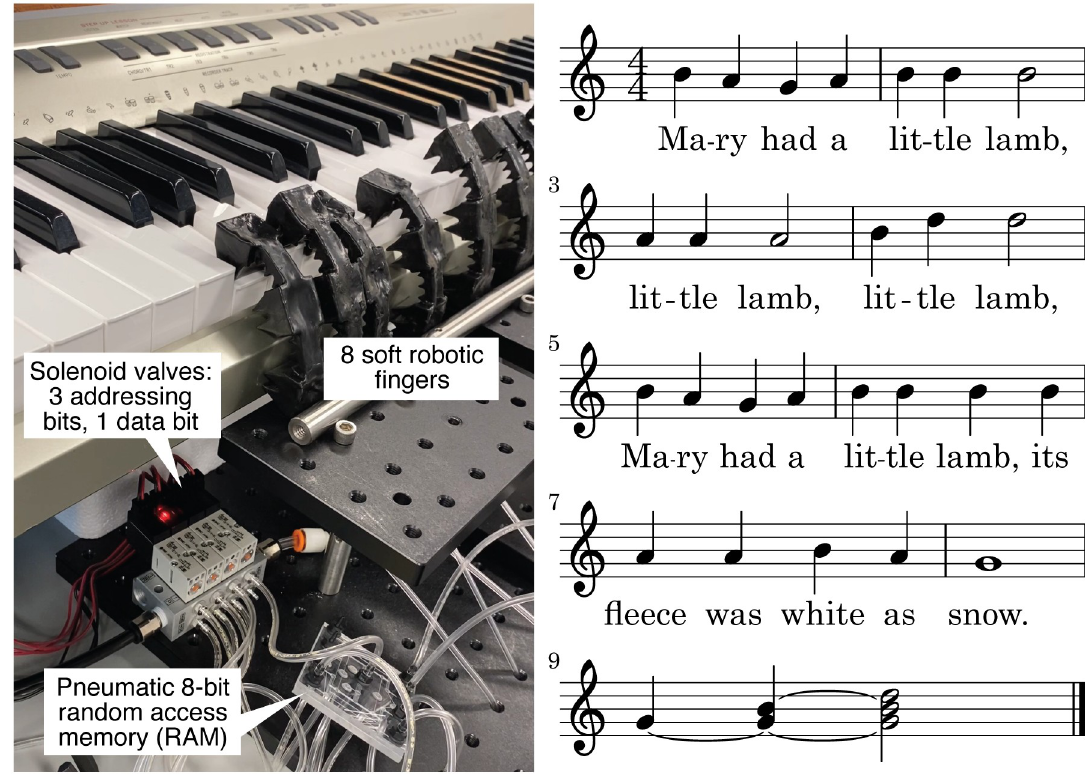
Fig 11. Video frame from using an eight-bit pneumatic RAM to control soft robotic fingers playing the music score shown on the right. The music consists of “Mary Had a Little Lamb” (measures 1 through 8; demonstrating playing one note at a time with varying durations) followed by an arpeggiated G-major chord (measure 9; demonstrating playing and holding multiple notes simultaneously). Source video available as online Supplementary Information .